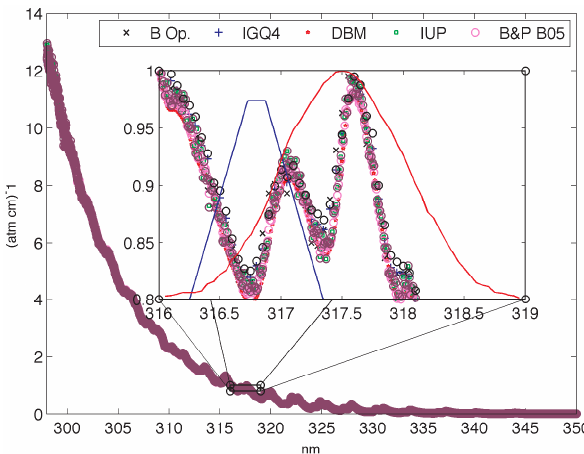
Fig. 1. The cross sections used in this study (Brewer operative Bass and Paur (BOp); Bass and Paur IGACO quadratic fit (IGQ4); Dau- mont, Brion and Malicet (DBM); Bremen Institute of Atmospheric Physics (IUP); and Bass and Paur of Bernhard (B05) at 228K) vs. wavelength. Also shown are the representative slit functions of Brewer and Dobson instruments in the spectral region of